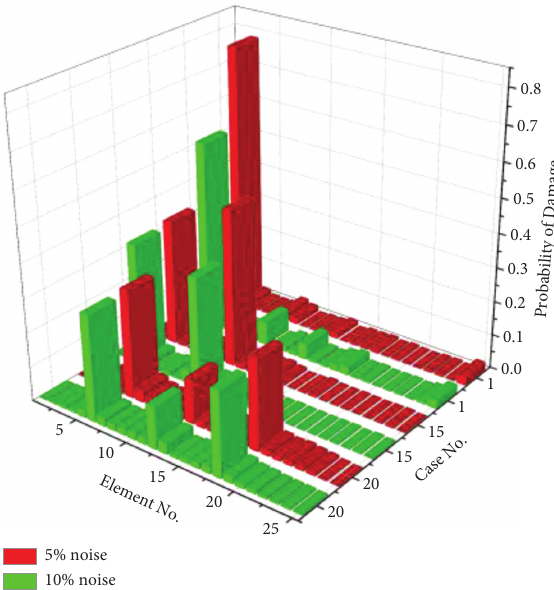
Figure 17: Antinoise analysis results of the second-level fusion